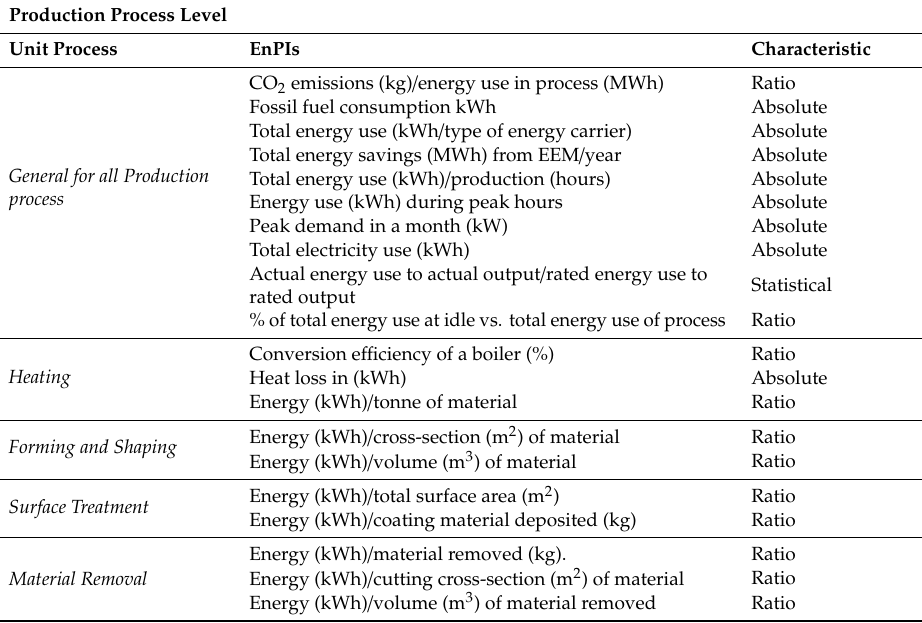
Table 7. Identified EnPIs for production processes for the engineering